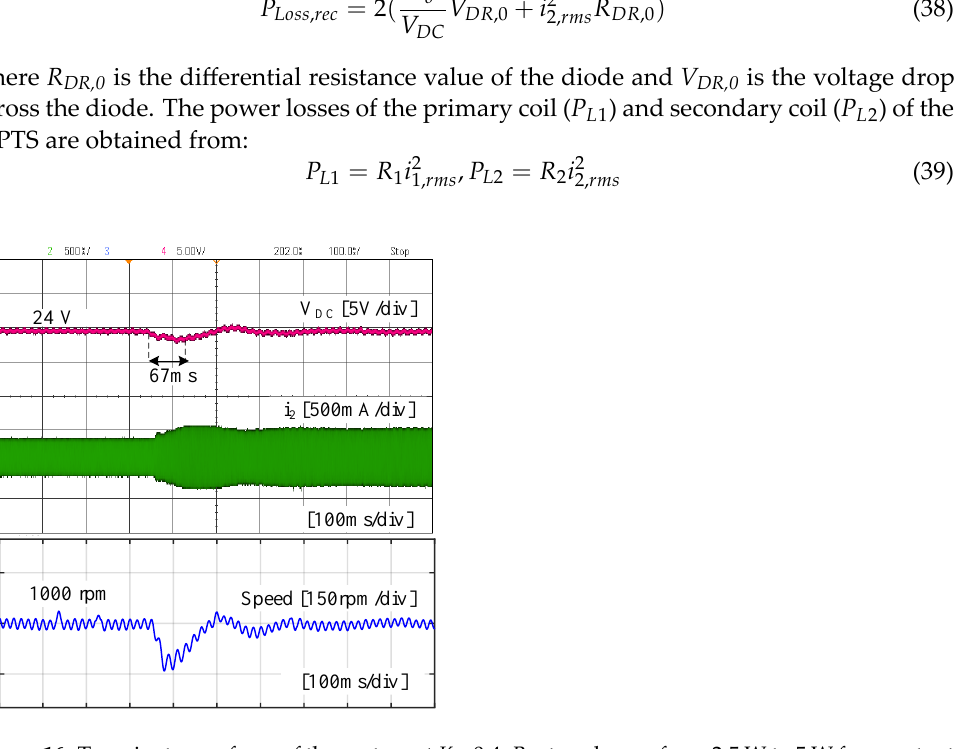
Figure 15. MET strategy for K = 0.5 ( a ) steady-state waveforms of the WPTS at P o = 2.5 W ( b ) steady- state waveforms of the WPTS at P o = 5 W ( c ) transient waveform of the system at P o step change from 2.5 W to 5 W.